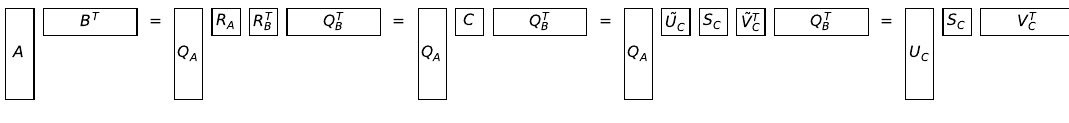
Figure 6. Visualizing the calculation of the exact SVD of a product via QR